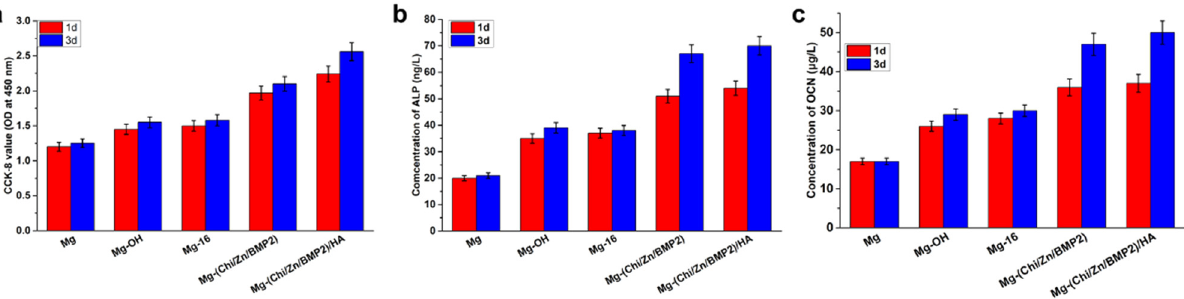
Figure 6: ( a ) Proliferation of osteoblast cells on di ff erent surfaces after 1 and 3 days evaluated by CCK - 8 test. ( b ) and ( c ) show the ALP and OCN activities of osteoblast cells on di ff erent surfaces after culture 1 and 3 days, respectively. Data presented as mean ± SD ( n = 3 ) and analyzed using one - way